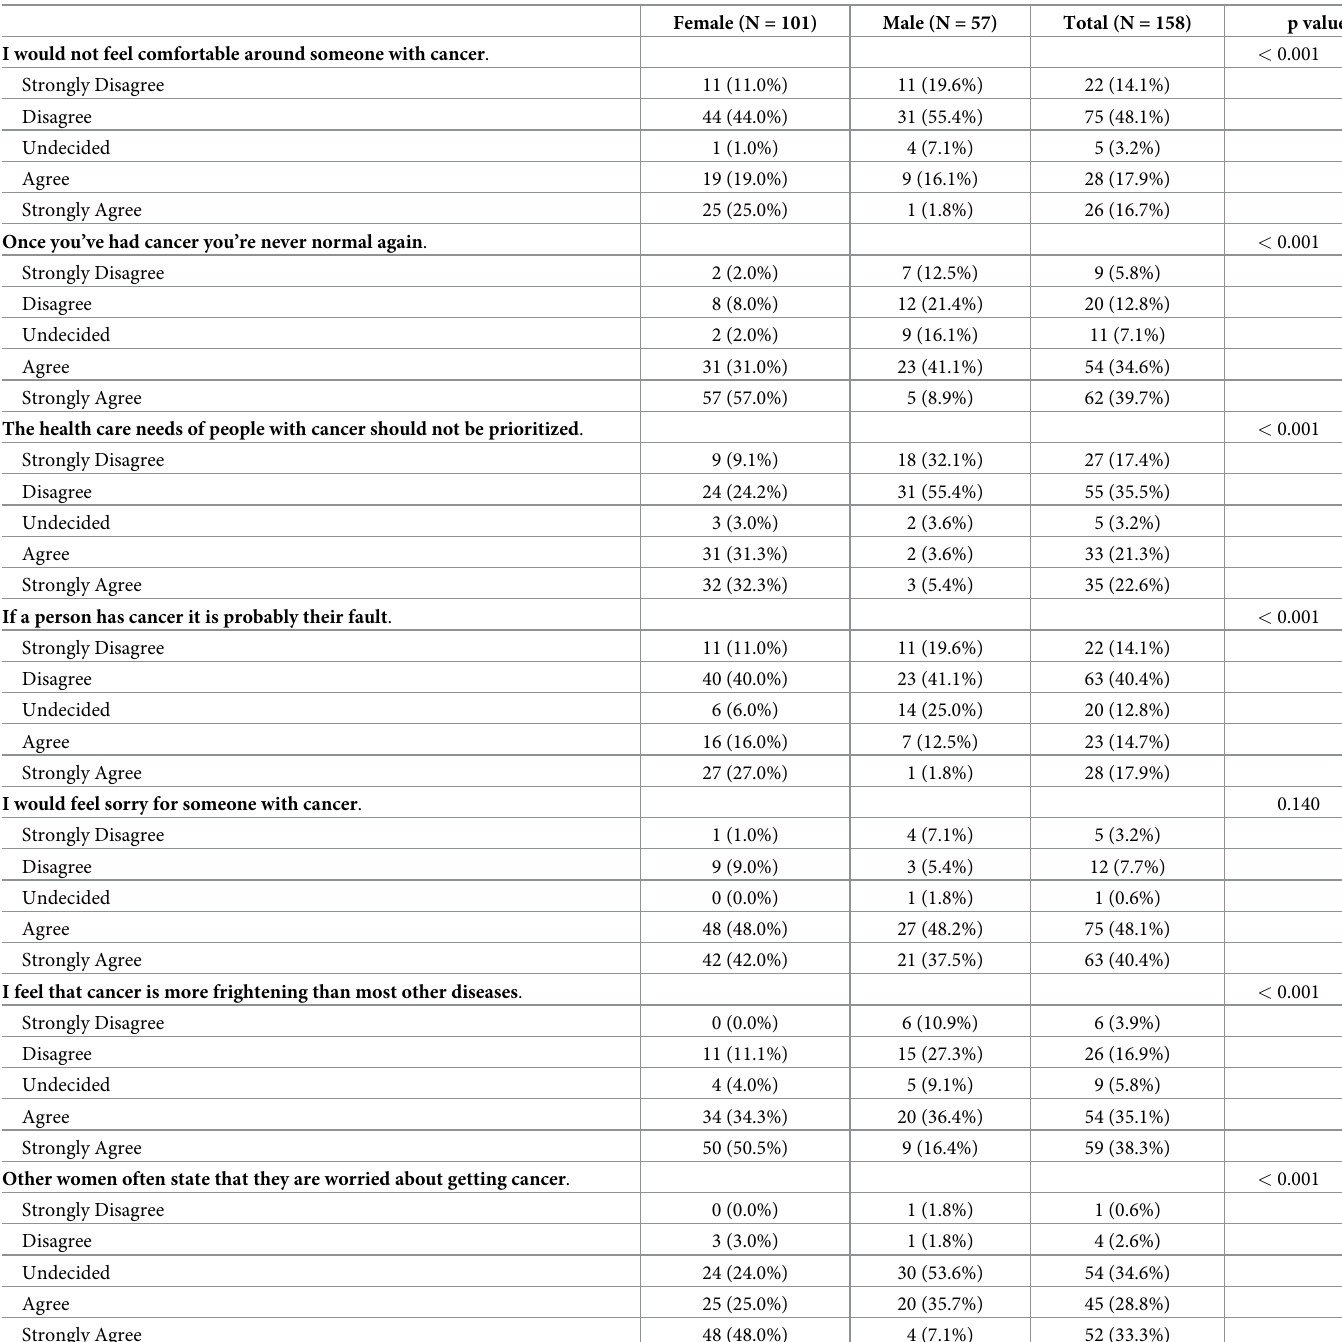
Table 4. Adapted cancer stigma scale by